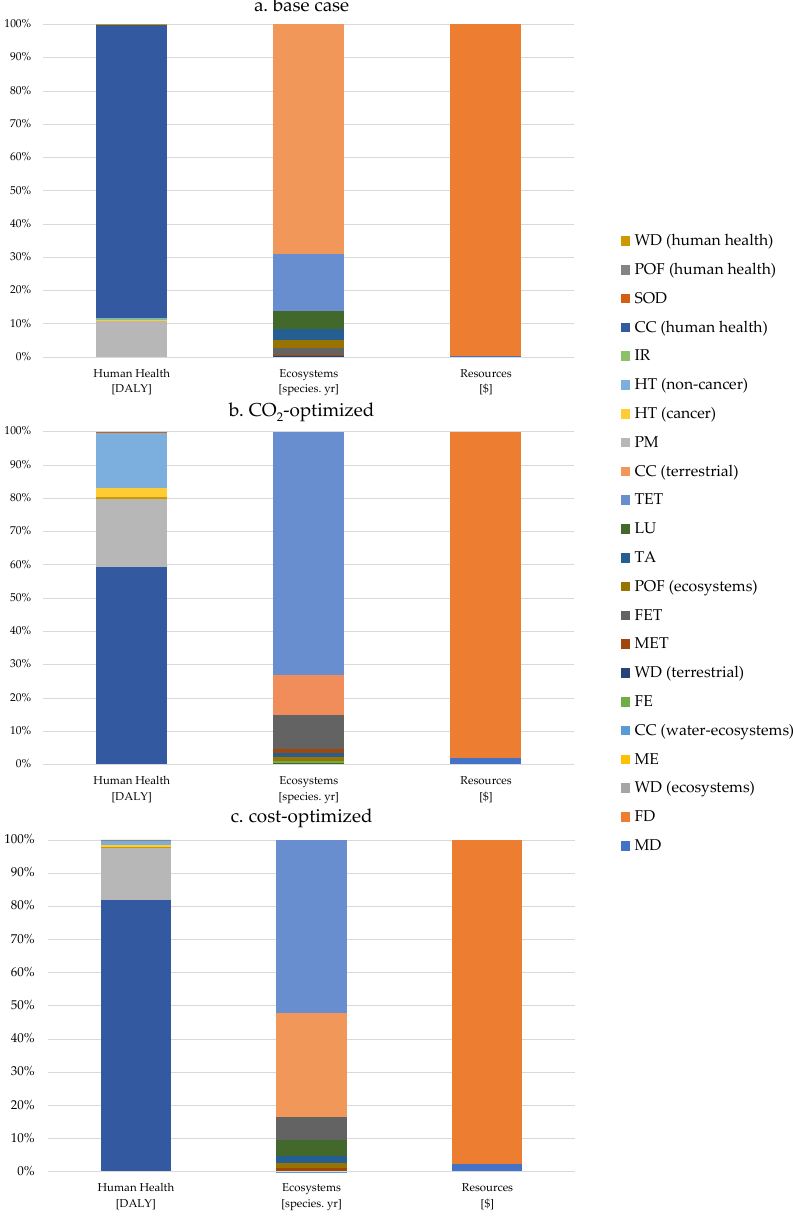
Figure 8. The figure shows the percentage distribution in each scenario at endpoint level. Up to down: base case, CO 2 -optimized, cost-optimized. Corresponding impact categories to each endpoint level in the following. Human Health: WD (human health), POF (human health), SOD, CC (human health), IR, HT (non-cancer), HT (cancer), PM | Ecosystems: CC (terrestrial), TET, LU, TA, POF (ecosystems), FET, MET, WD (terrestrial), FE, CC (water-ecosystems), ME, WD (ecosystems)| Resources: FD, MD. Abbreviations: FE = freshwater eutrophication, ME = marine eutrophication, PM = particulate matter formation, FET = fresh water ecotoxicity, HT = human toxicity, IR = ionizing radiation, CC = climate change, LU = land use, SOD = stratospheric ozone depletion, POF = photochemical ozone formation, MET = marine ecotoxicity, TET = terrestrial ecotoxicity, TA = terrestrial acidification, FD = fossil depletion, MD = metal depletion, WD = water